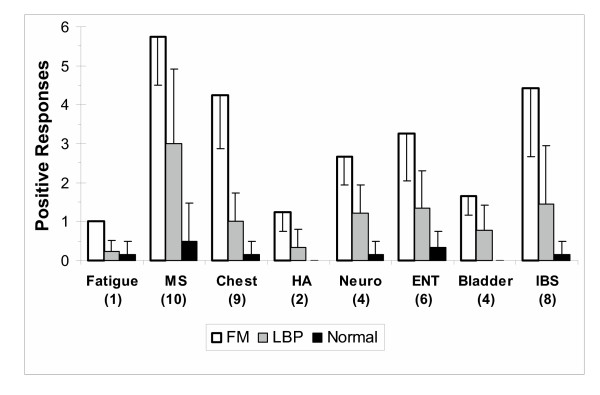
Systemic symptoms questionnaire results. FM (white bars), LBP (grey bars) and Normal (black bars) results are shown for each domain. The x-axis shows the systems domains with the total number of questions in parentheses. The y-axis shows the number of positive responses within each domain. The error bars are the 95% confidence intervals. FM scores were higher than Normal for ENT and IBS (p ≤ 0.05), Chest, Headache, Neurological and Bladder (p ≤ 0.01), Fatigue and Musculoskeletal (p ≤ 0.001). FM scores were higher than LBP for Neurological (p ≤ 0.05), Chest (p ≤ 0.01) and Fatigue (p ≤ 0.001). Normal and LBP scores were not different.